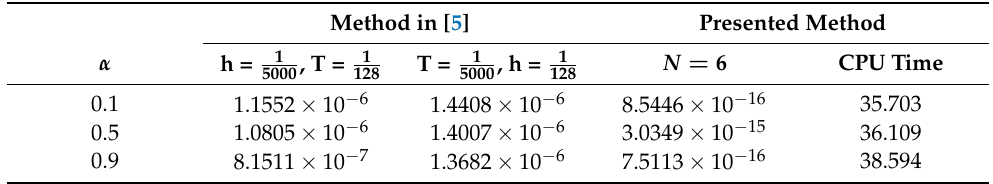
Table 1. The L 2 errors for Example 1.